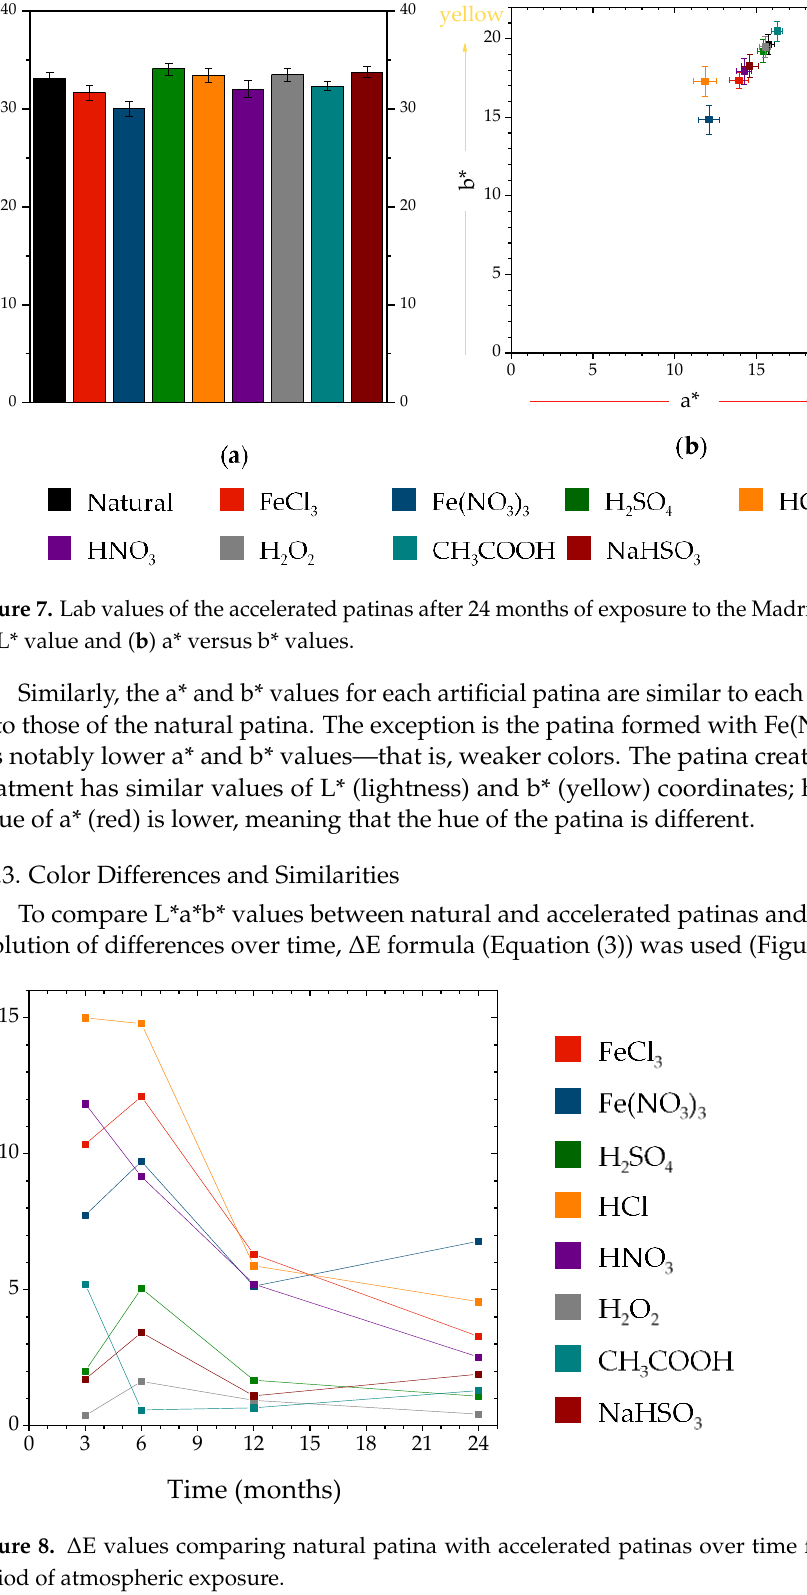
9 of 19 Figure 6. Lab values of the bare metal and the accelerated patinas at zero time: ( a ) L* value and ( b ) a* versus b* values.